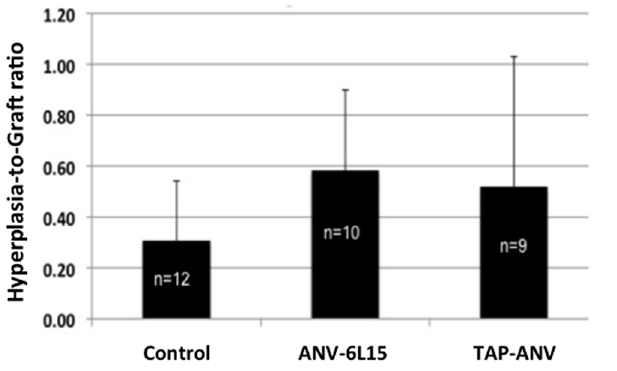
Fig 7. Effect of anti-thrombotic fusion protein treatment on hyperplasia-to-graft (H/G) ratios determined by histomorphometry. Control = heparin-treated. A value of 1.0 would indicate the graft was fully occluded with hyperplasia. A value of 0.0 would indicate no hyperplasia. There was no significant difference in the H/G ratio amongst the treatments groups. The bars represent means ±